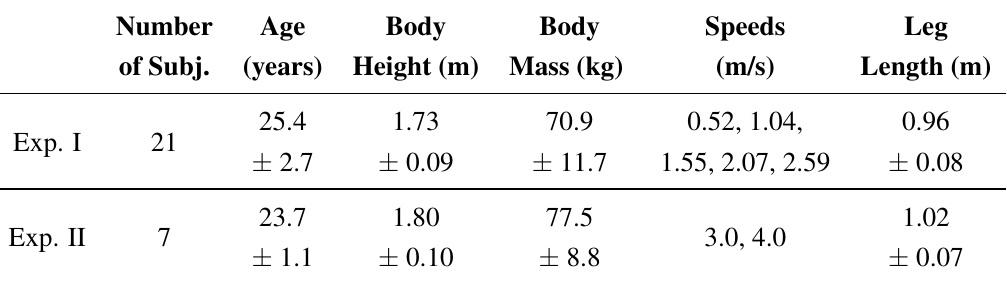
Table 1. Experimental and subject characteristics (mean ±